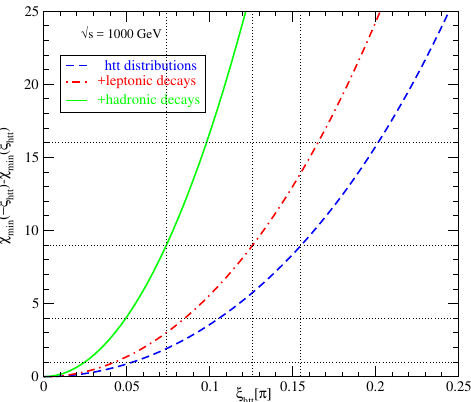
Figure 14 . Sensitivity to CP violation is shown by (cid:31) 2 against (cid:24) ex , the assumed true value of the CP phase at p s = 1000 GeV. htt